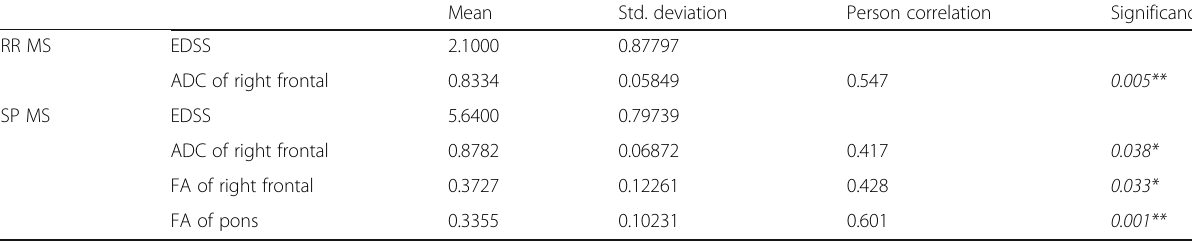
Table 4 Correlation between ADC/FA per region and EDSS in both MS groups Mean Std. deviation Person correlation Significance